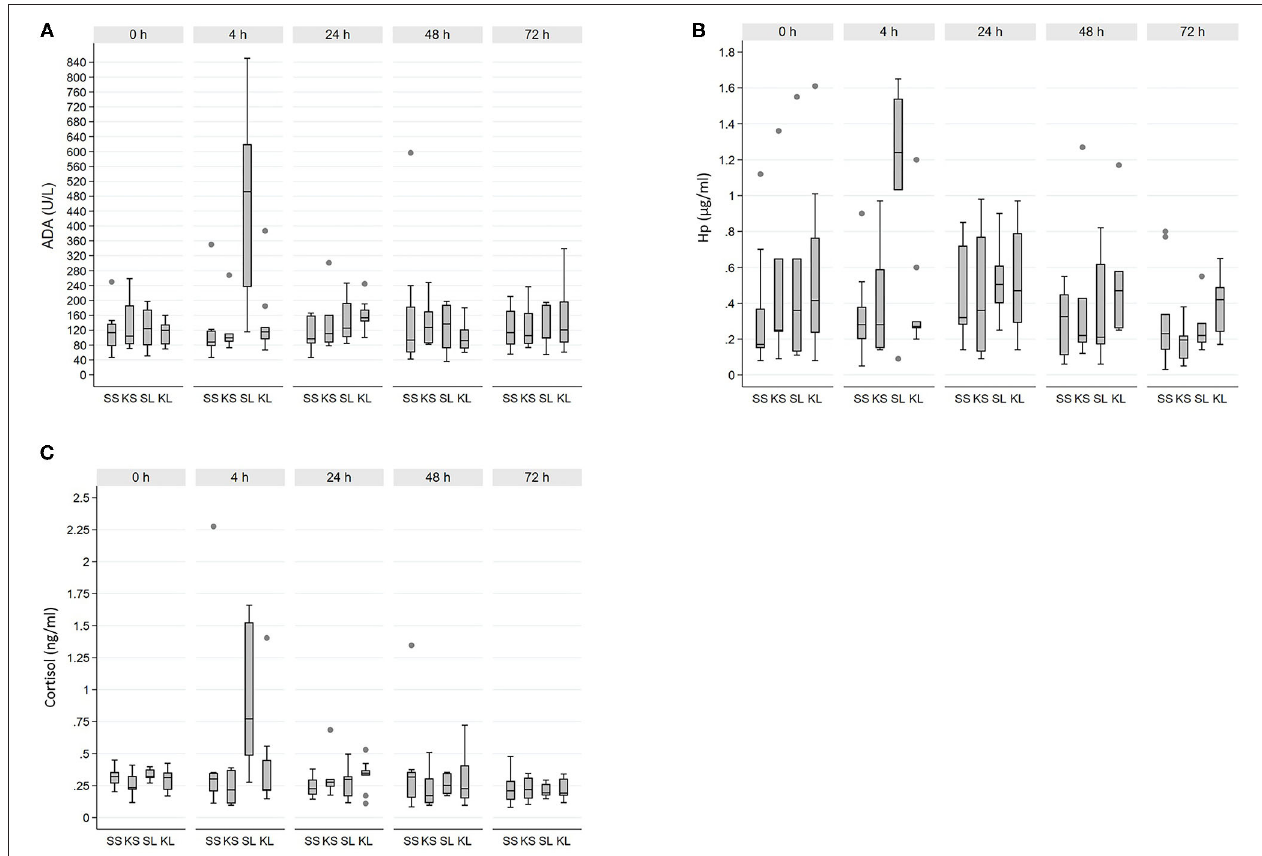
FIGURE 1 | Raw values of salivary (A) adenosine deaminase (ADA), (B) haptoglobin (Hp), and (C) cortisol across 32 experimental pigs. SS, saline-saline; KS, ketoprofen-saline; SL, saline-LPS; KL,